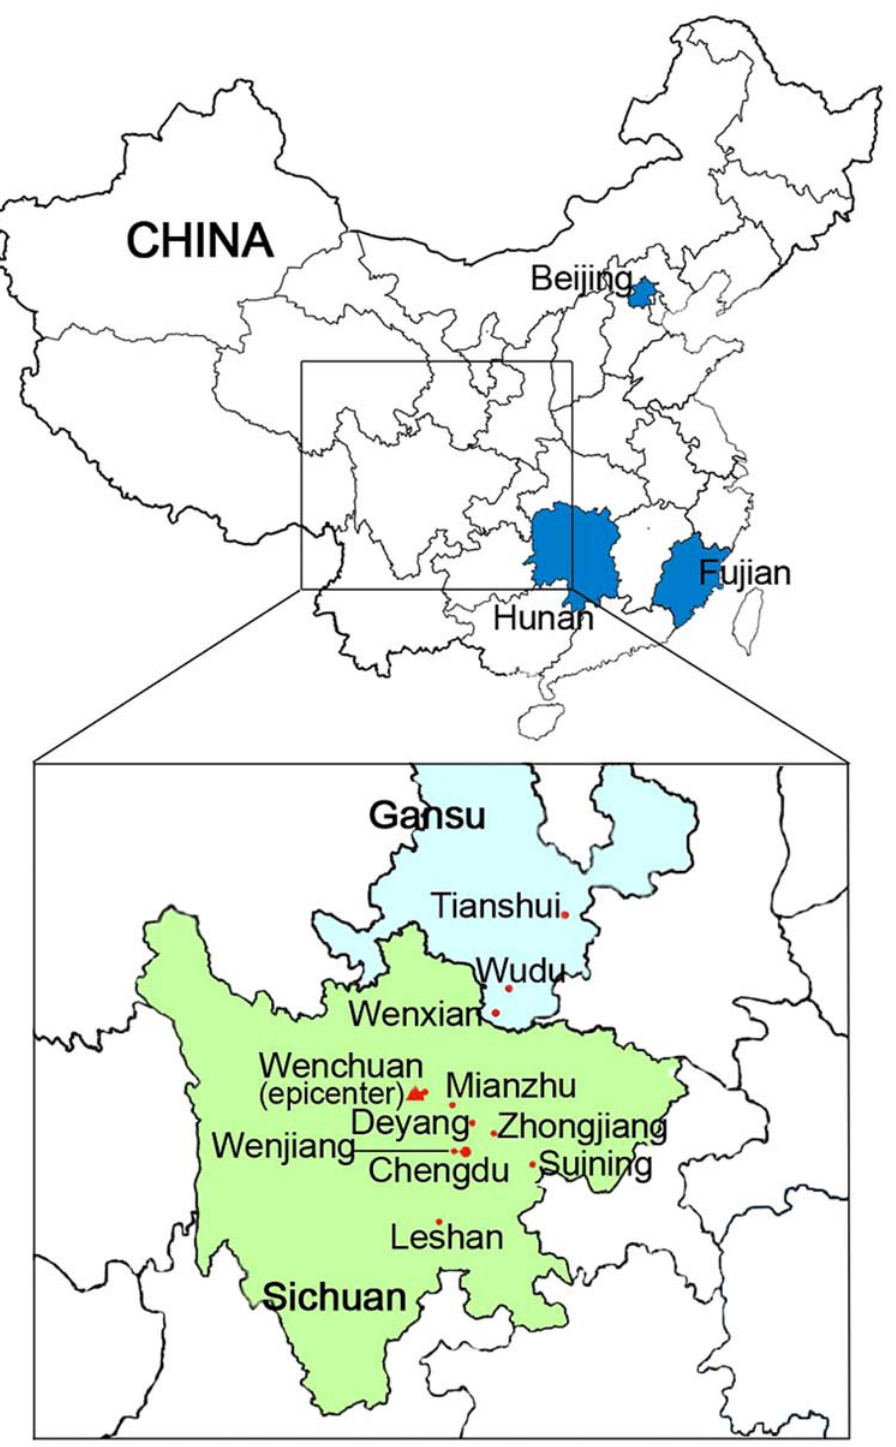
Figure 1. Sampling Frame in Relation to the Epicenter. The sampling frame includes three non-devastated areas indicated by blue shading (Fujian Province, Hunan Province and Beijing) and eleven devastated areas indicated by red dots (Wenchuan, Chengdu, Wenjiang, Suining, Leshan, Deyang, Zhongjiang, and Mianzhu in Sichuan Province, and Tianshui, Wenxian and Wudu in Gansu Province). This figure was plotted by Li-Rong Zhang.